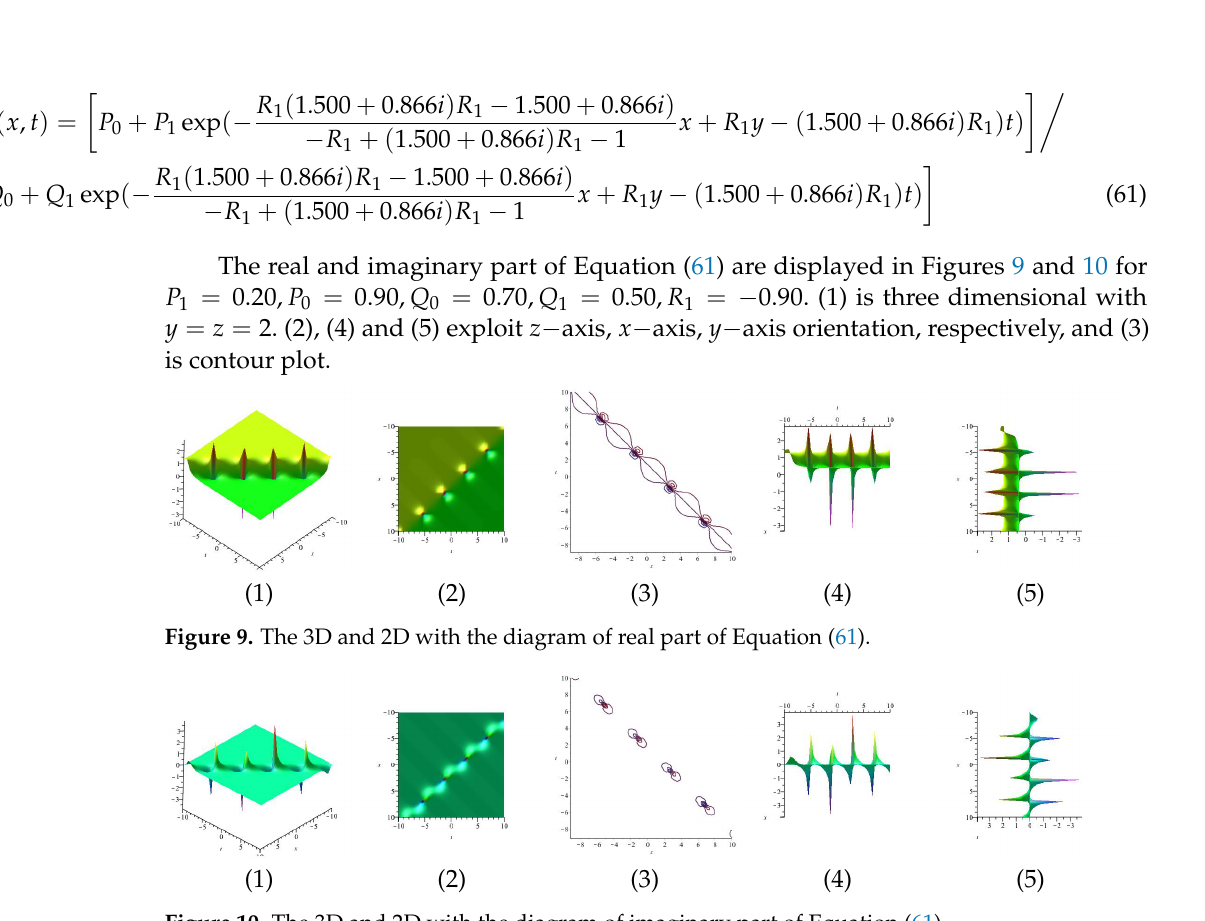
Figure 10. The 3D and 2D with the diagram of imaginary part of Equation